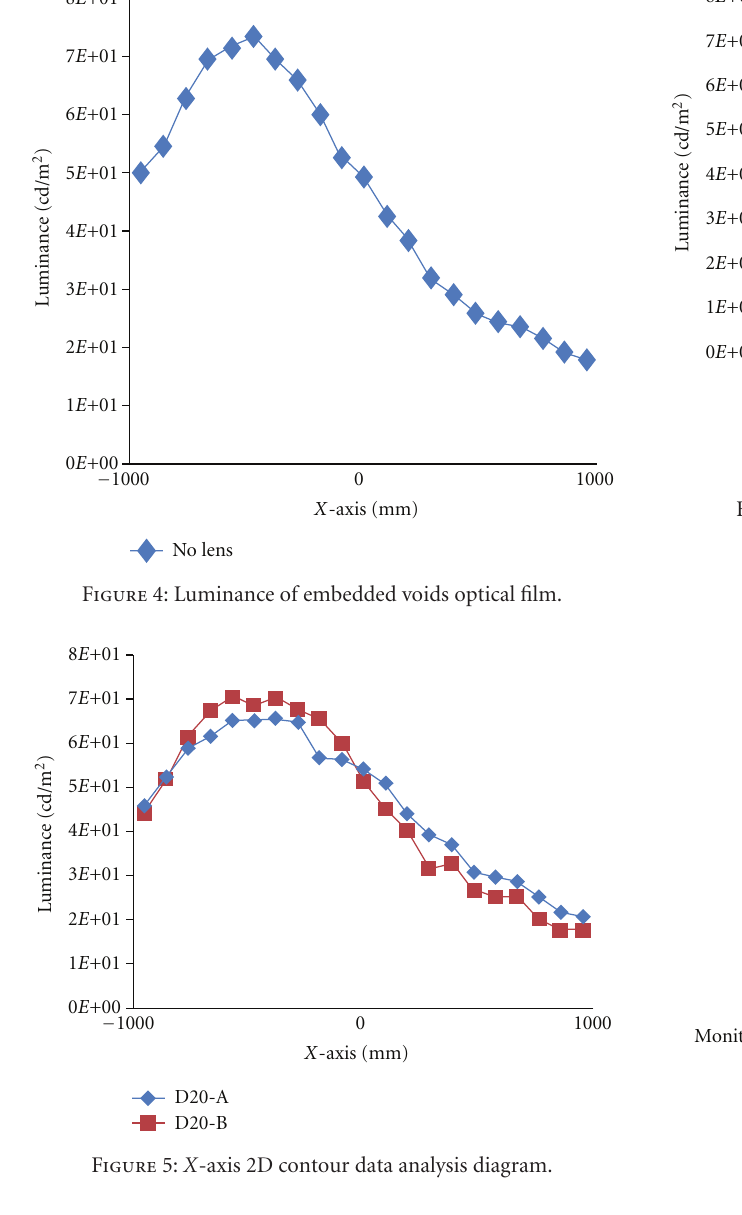
Figure 8: Gray scale mask production sketch. Table 2: Gray scale microlens array simulated average luminance and